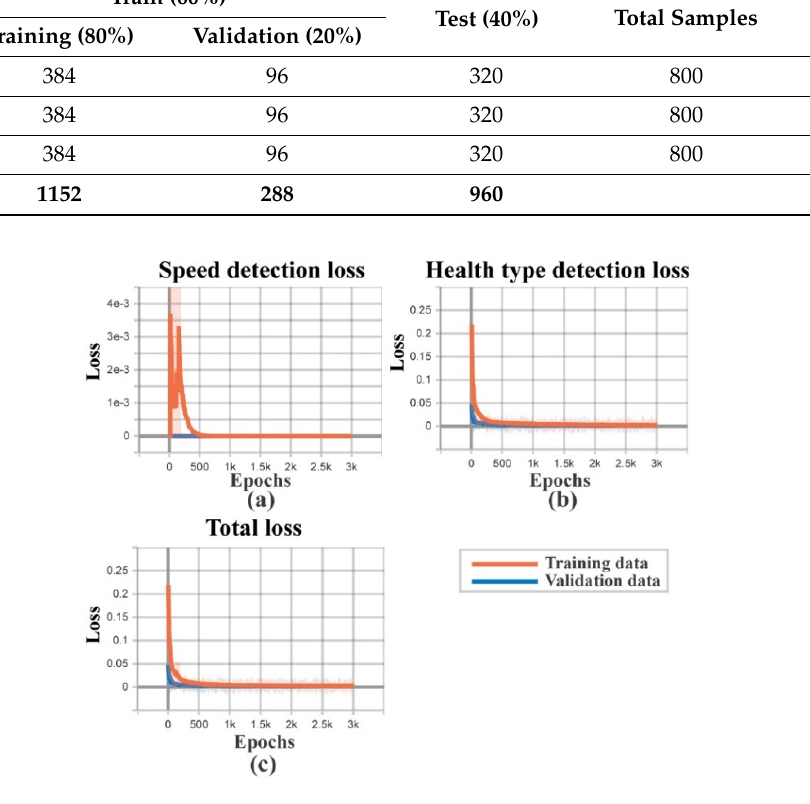
Table 2. The train, test, and validation dataset ratios.